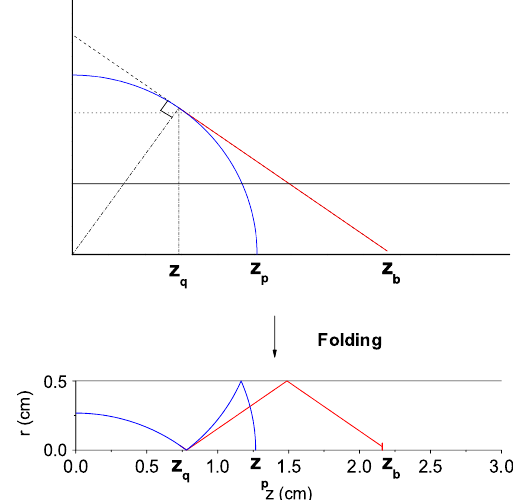
FIG. 5. (Color) Electric field lines of the wakefield when a beam (red: Cerenkov radiation; blue: transient passes through z ¼ z b radiation). Radiation lines in a semi-infinite waveguide (below) can be obtained by folding lines in a space without radial boundary (above) on the radial